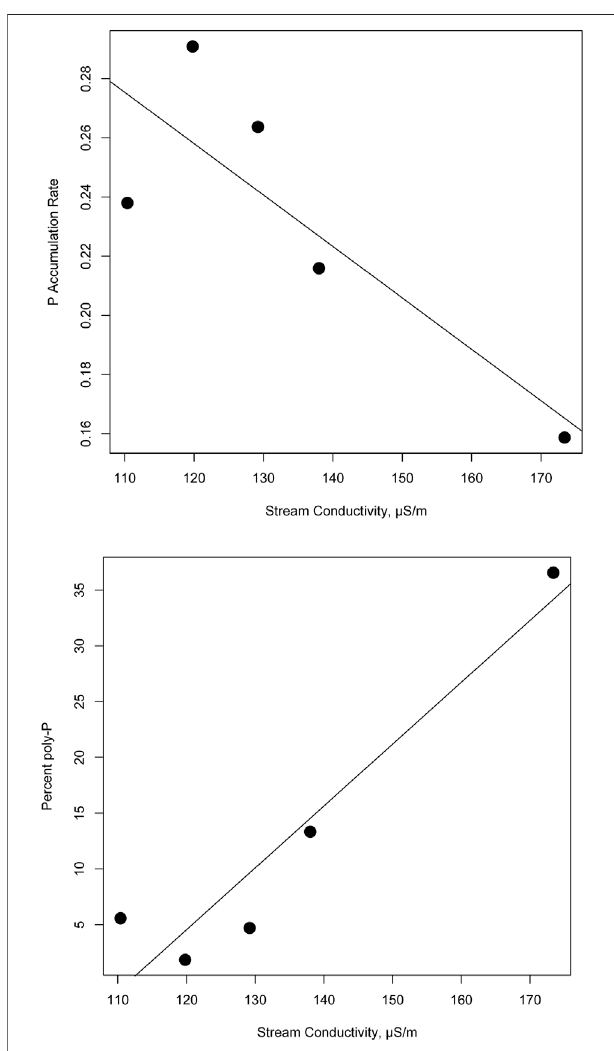
FIGURE4| Simplelinearregressionsdepictingtherelationshipbetween stream water conductivity (proxy for legacy nutrients in μ S/cm) versus estimatespercentpolyPstorage(Toppanel), p =0.01onnaturalstreamrocks andpolyPuptake(Bottompanel), p =0.08derivedfromaseriesofinsitu